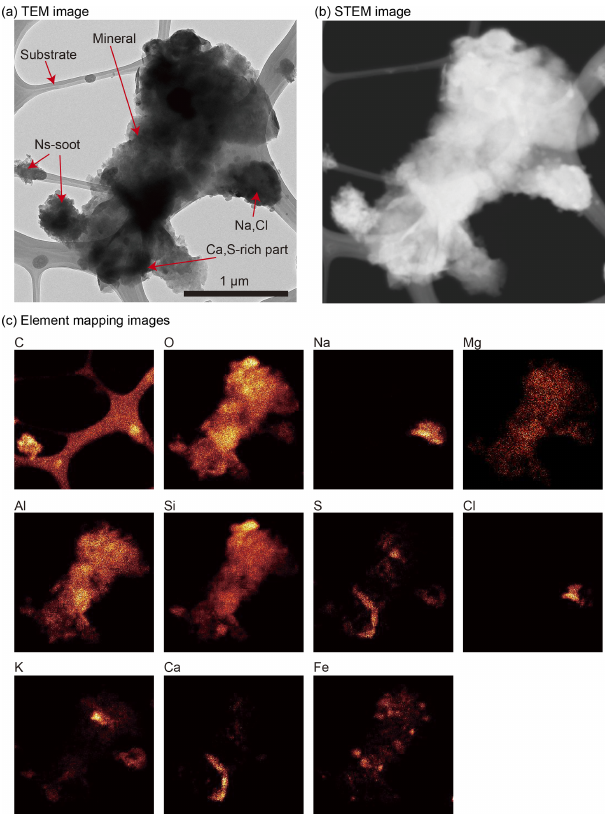
Figure 6. Shape and compositions of mineral particles. (a) TEM, (b) STEM, and (c) element mapping images of a mineral particle. This particle was obtained from the sample collected during 15:00– 15:30 on 2 March 2014 on a lacey carbon